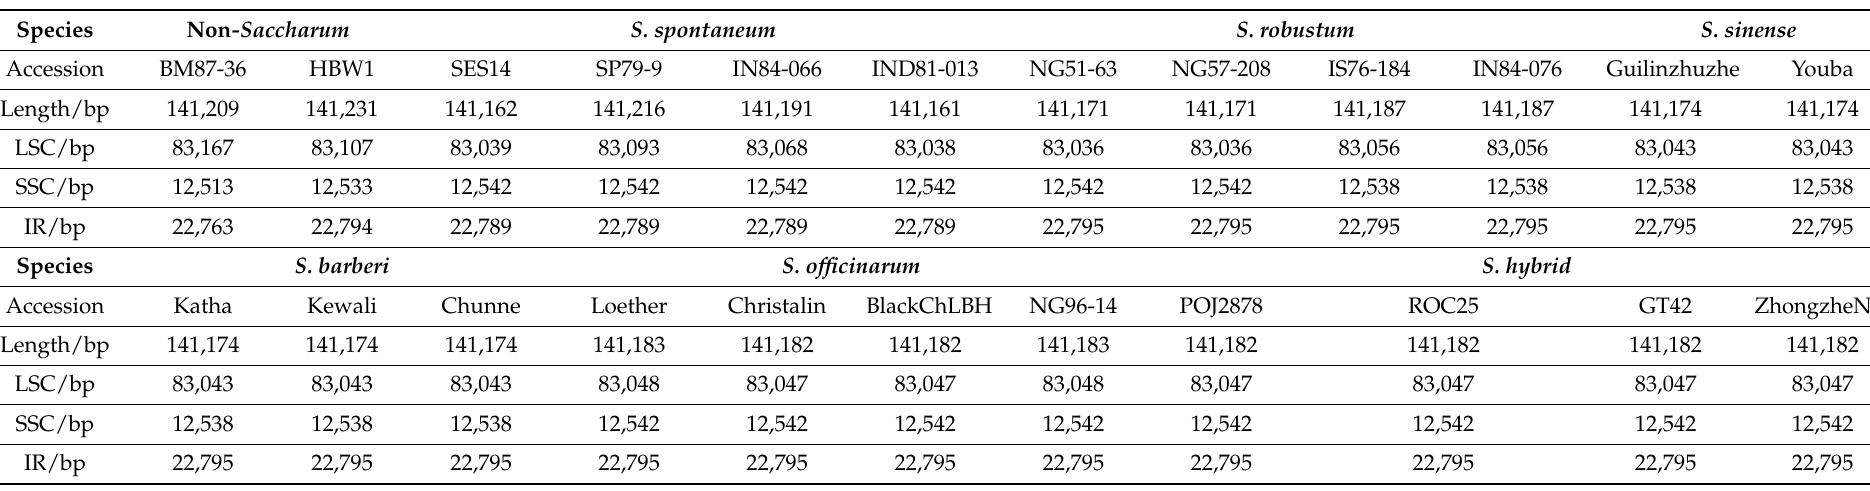
Table 1. The structure and length of the chloroplast genome sequences in N. porphyrocoma , T. arundinaceum , and Saccharum spp. assembled in this